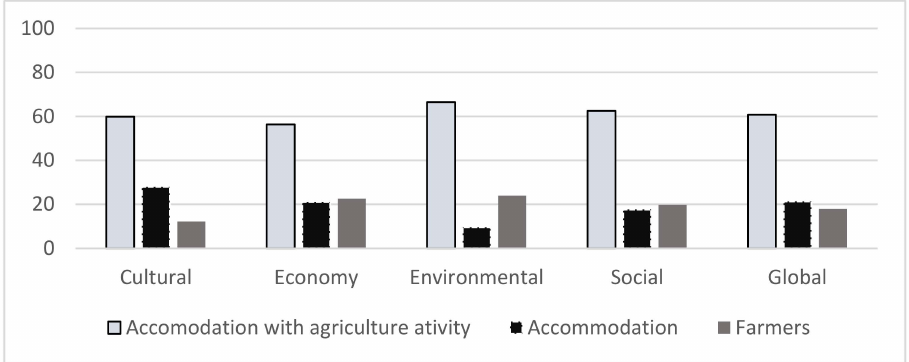
Figure 4. Main impacts of tourism and farming activities